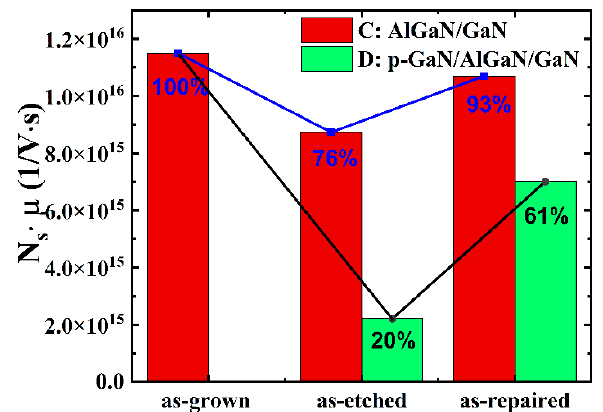
Figure 4. ( a ) The N s and the µ of sample C in different states, ( b ) the N s and the µ of sample D in different states.